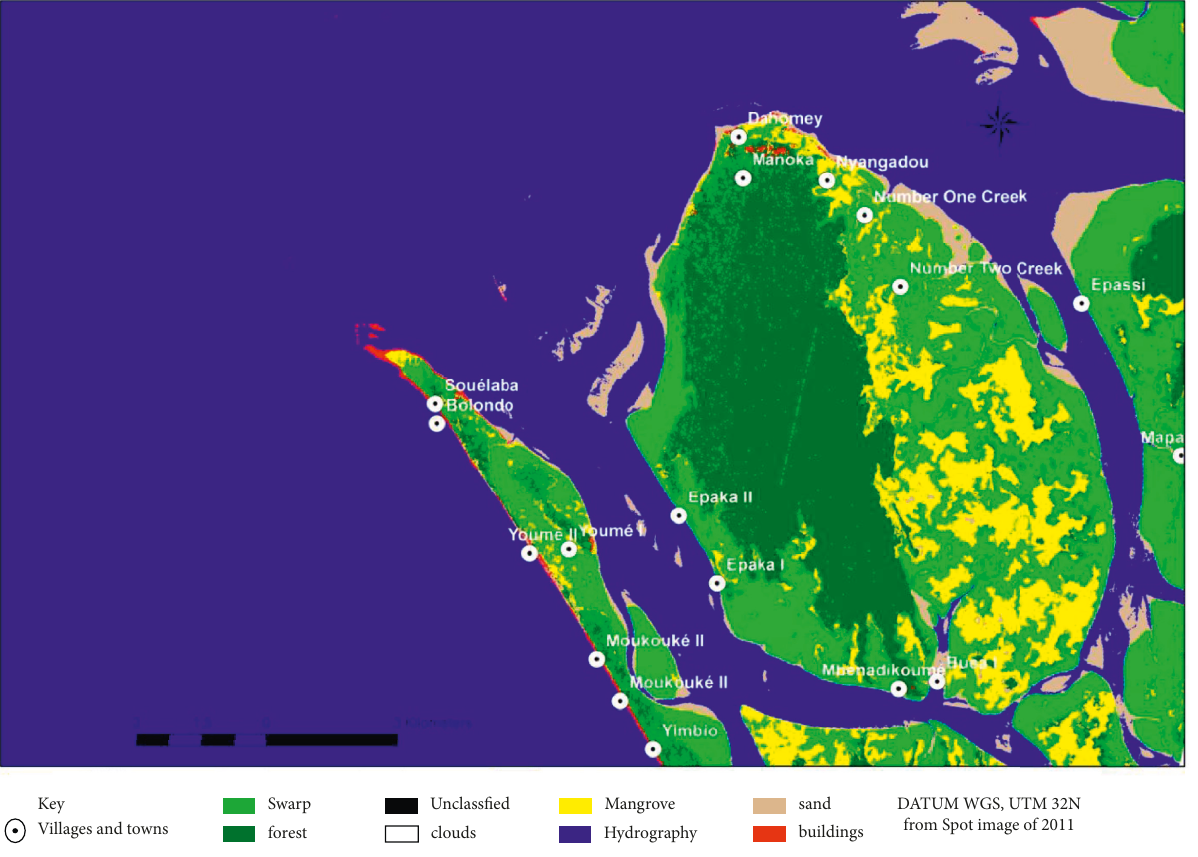
Figure 2: Land cover map of Manoka Island.